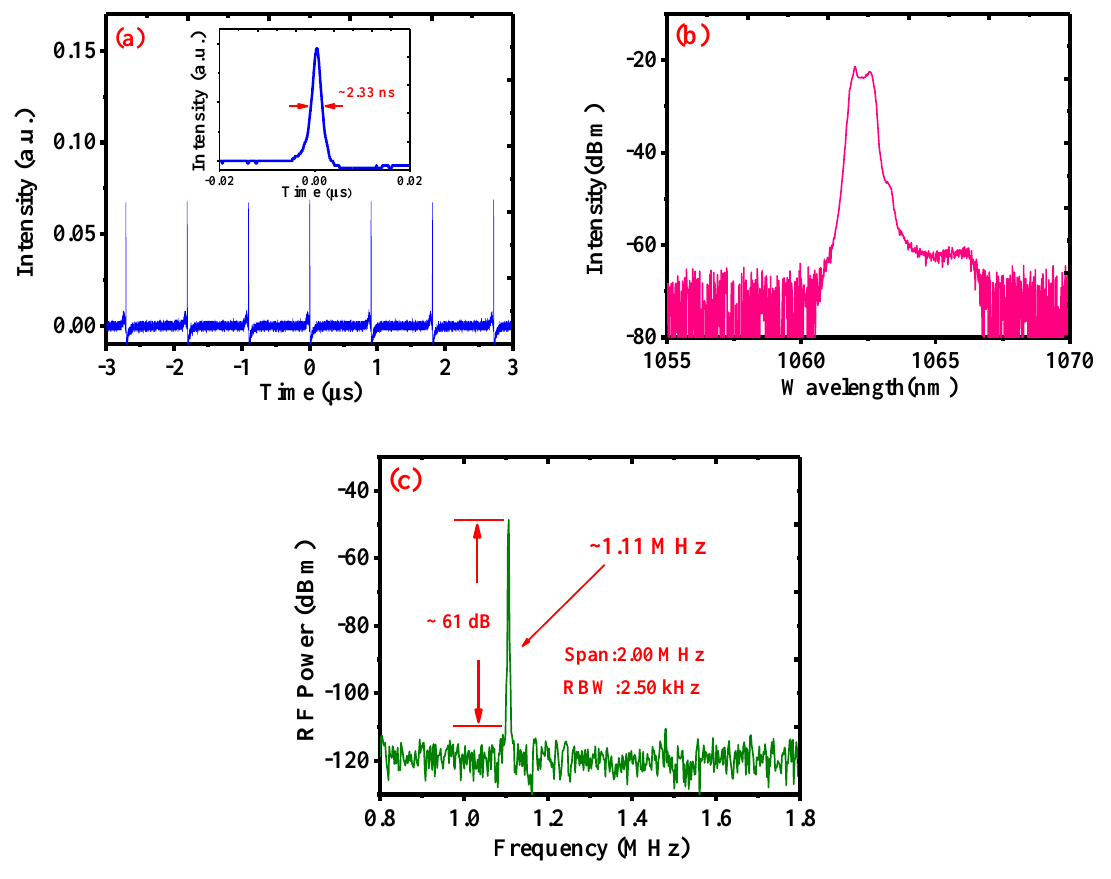
Figure 5. ( a ) Fundamental mode-locking pulse train. Inset: single pulse width. ( b ) Corresponding spectrum. ( c ) Fundamental frequency